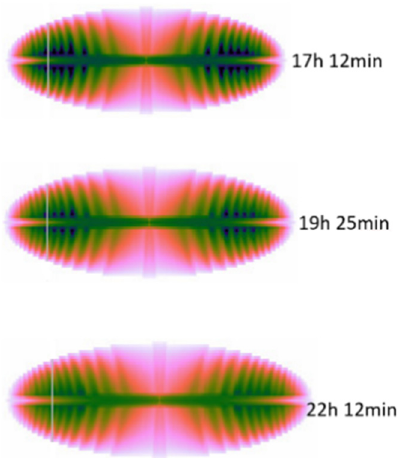
Figure 31. The distribution of saturation at different moments of time.